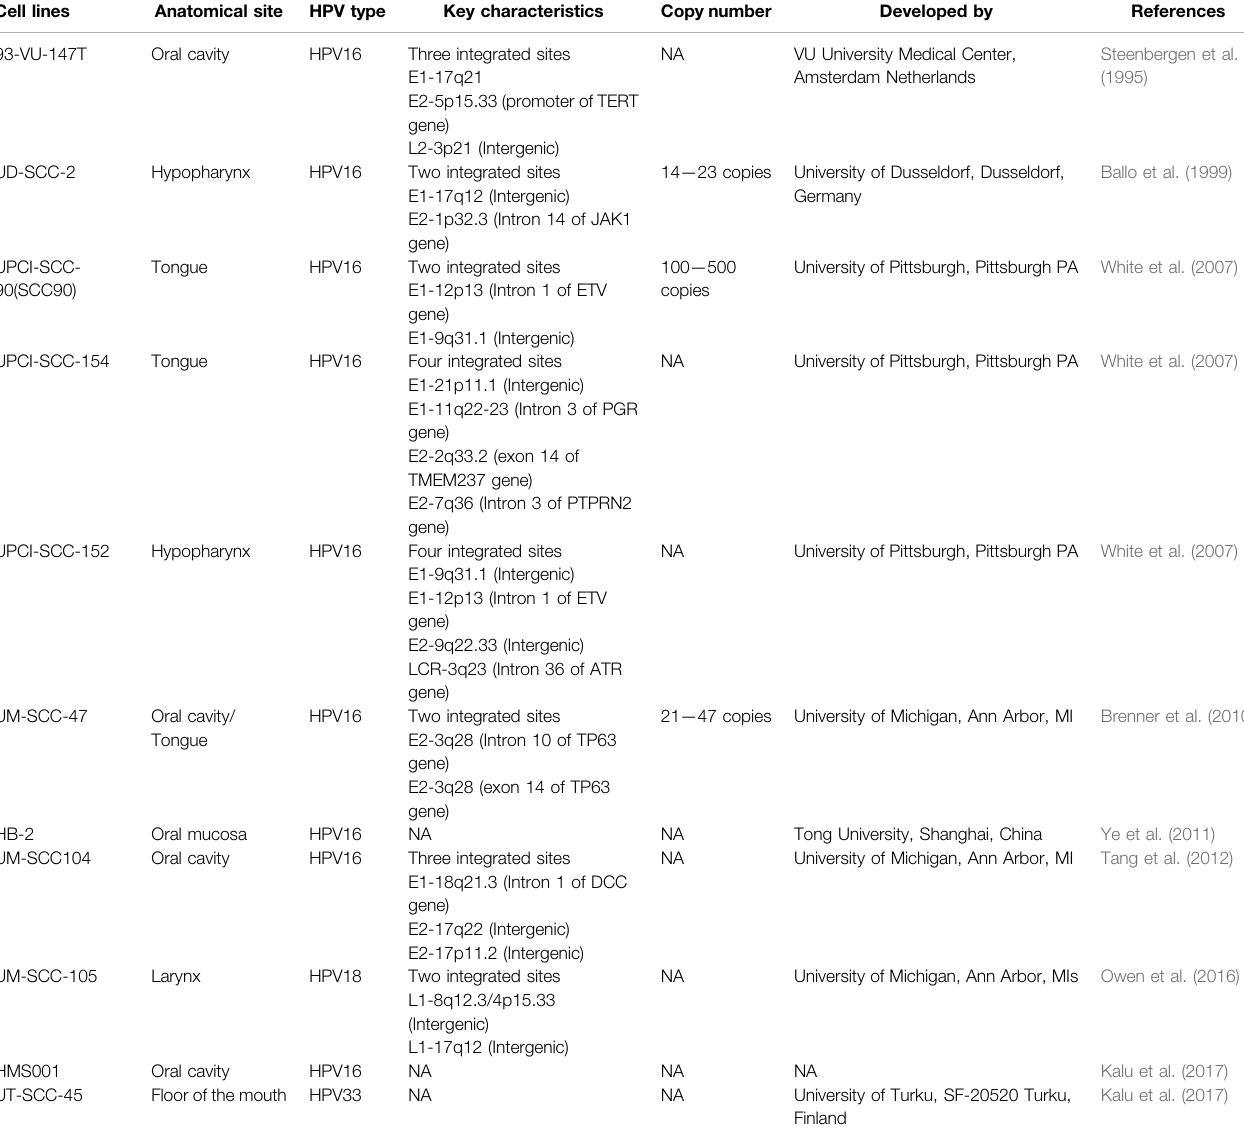
TABLE 8 | List of HPV positive Head and neck cancer cell lines developed and described with their key characteristics. Cell